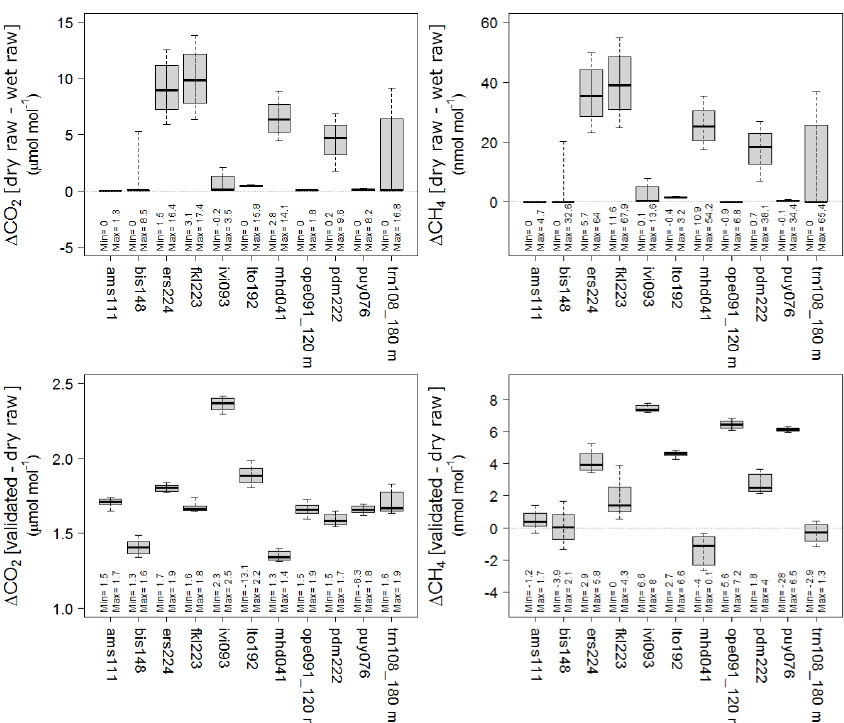
Figure 7. Synthesis of the water vapor (above) and calibration (below) corrections applied to 11 instruments in 2014 for hourly mean CO 2 (left) and CH 4 (right) mole fractions. The length of the box represents the interquartile range, the horizontal line represents the median and the low and high whiskers show 10 and 90% percentiles, respectively. Numbers below the box plots give the maximum and minimum corrections. It should be noted that the calibration corrections depend on the calibration settings of the analyzers. several times, and the calibration sequence is defined as m times the repetition of the unitary cycle element (Fig.